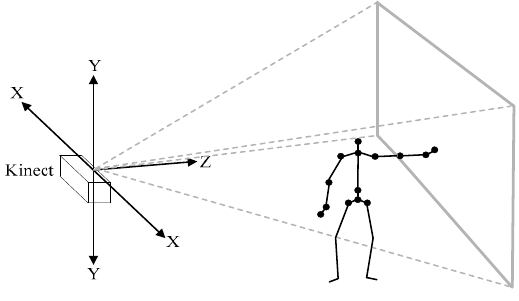
Figure 2. Depth image space created by the Kinect sensor.